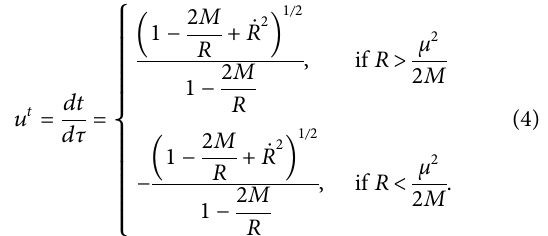
Frontiers in Physics |